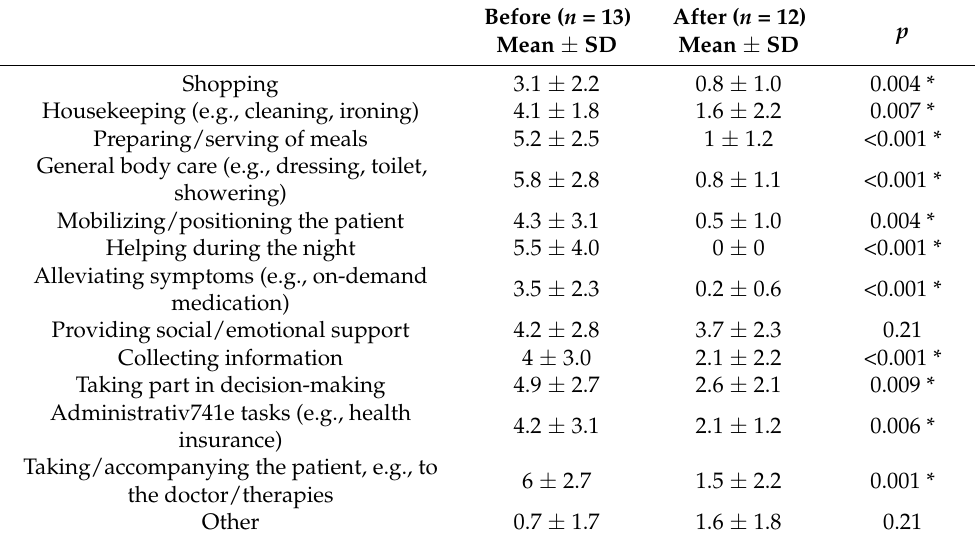
Table 3. Change of caregiving task questionnaire results before and after